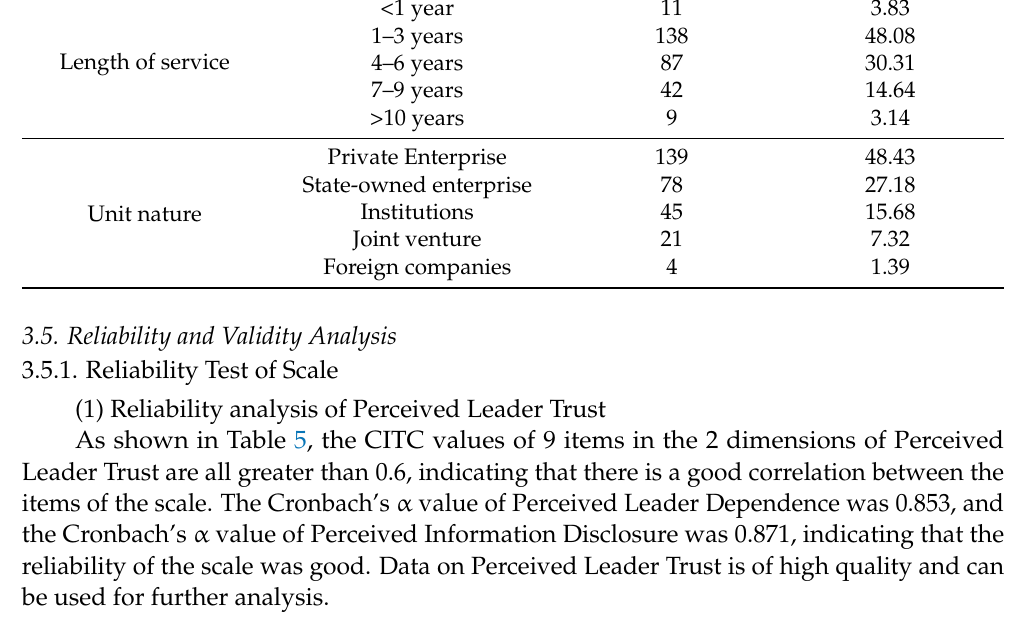
Table 5. Reliability Analysis of Perceived Leader